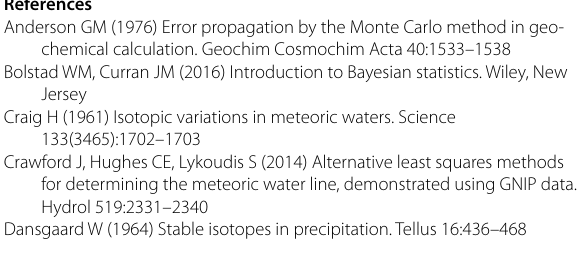
measurement uncertainties for both δD and δ 18 O and to test whether the slopes and intercepts calculated by the OLS and TLS are statistically significantly differ- ent. Although the TLS method is theoretically more suited to linear regression for stable water isotopes than OLS, the application of the widely used OLS method can be still regitimate in the case of small measurement uncertainties.